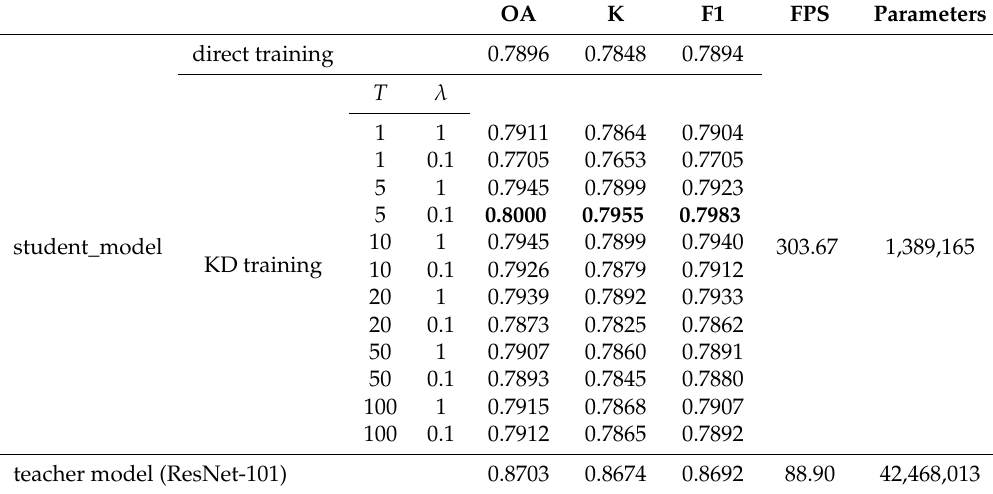
Table 8. Results of Knowledge Distillation training experiments on NWPU-RESISC